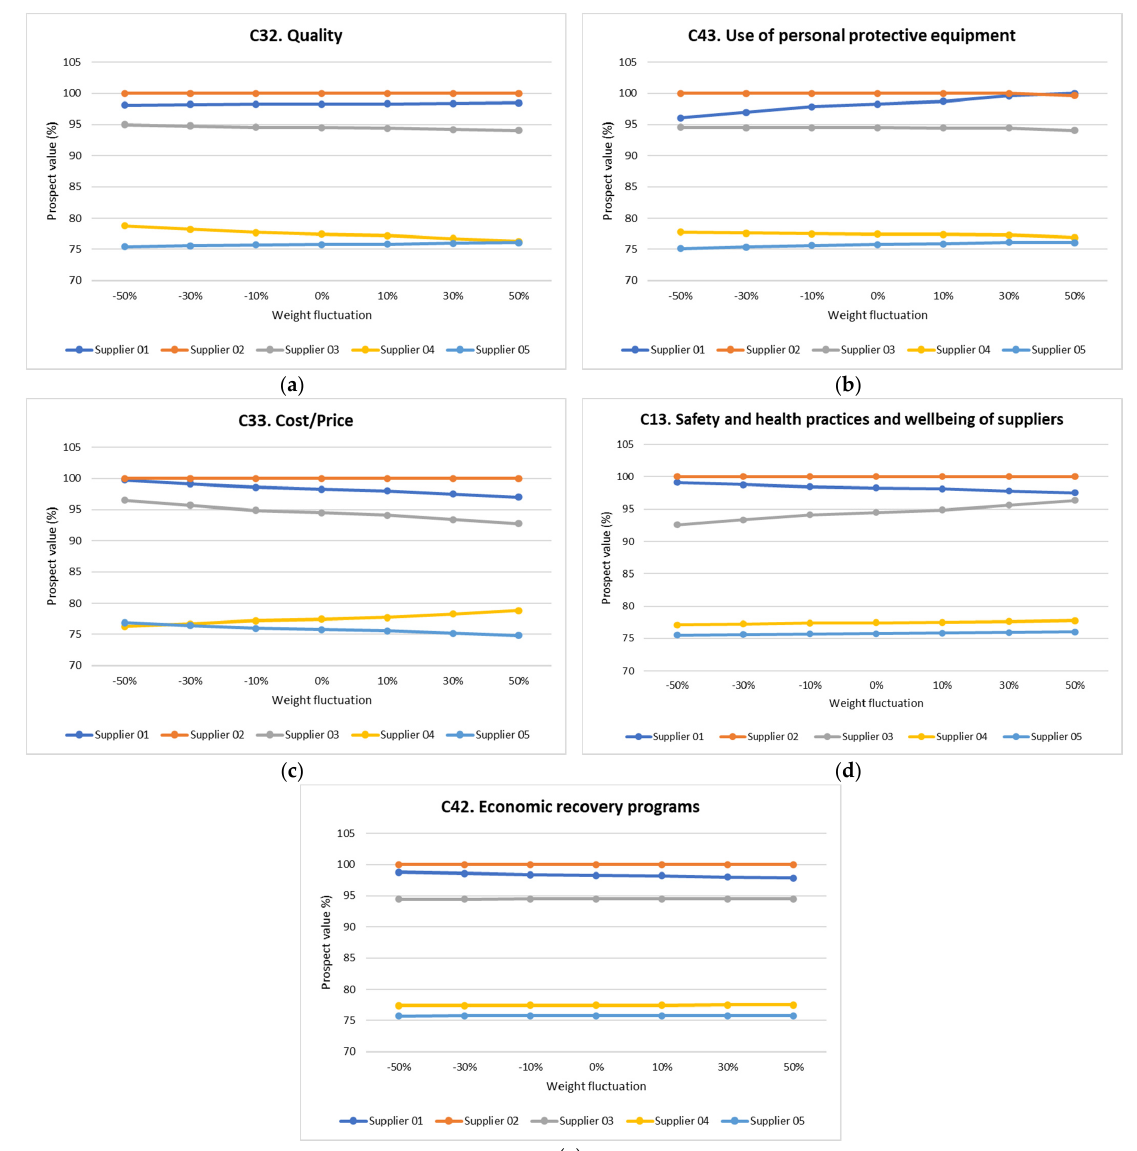
Figure 5 . Sensitivity analysis of criteria ( a ) C32. Quality, ( b ) C43. Use of personal protective equipment, ( c ) C33. Cost/Price, ( d ) C13. Safety and health practices and wellbeing of suppliers, ( e ) C42. Economic recovery programs.